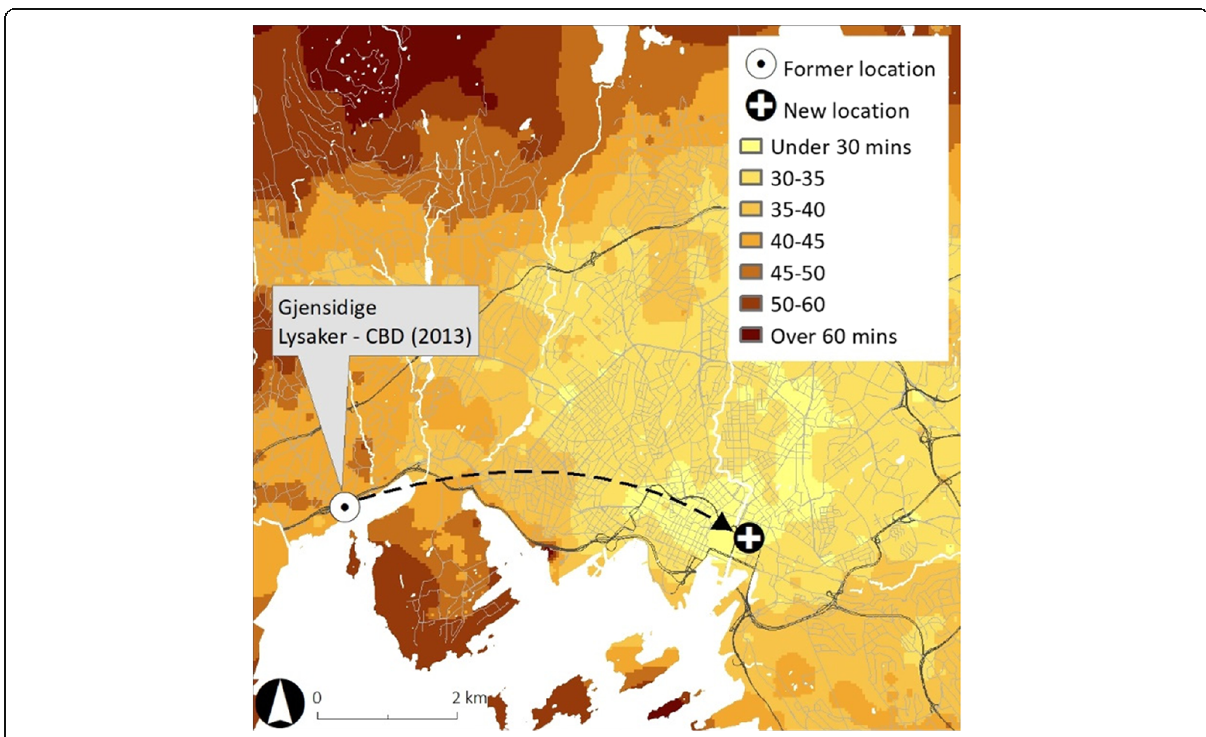
Fig. 2 The former and new locations (see the label and arrow direction) of the insurance firm Gjensidige in